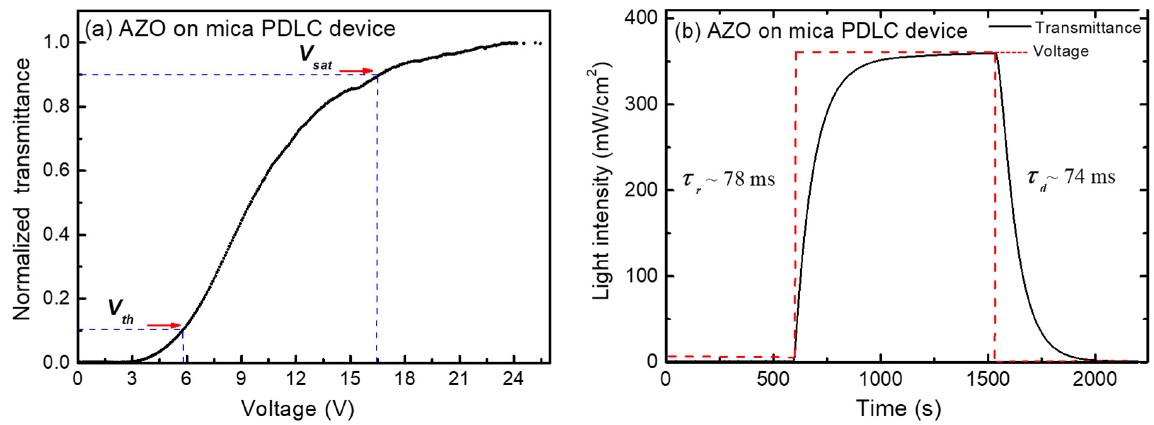
Figure 7. ( a ) Voltage-transmittance curve of AZO on mica PDLC device and ( b ) response time of AZO on mica PDLC device.